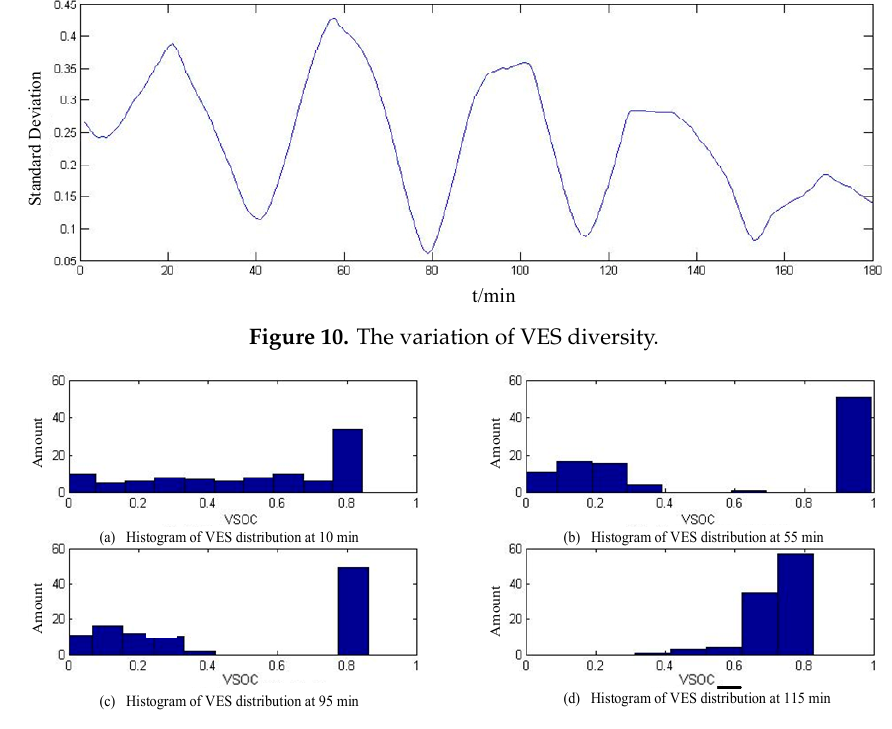
Figure 11. Histograms of VES distribution at different time points.